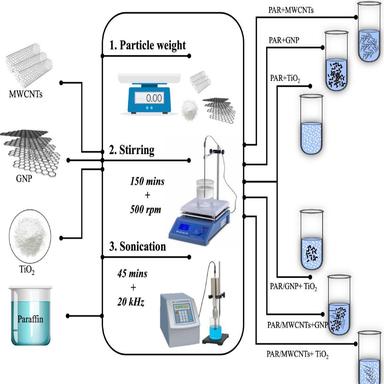
Schematic illustration of the two-step method.